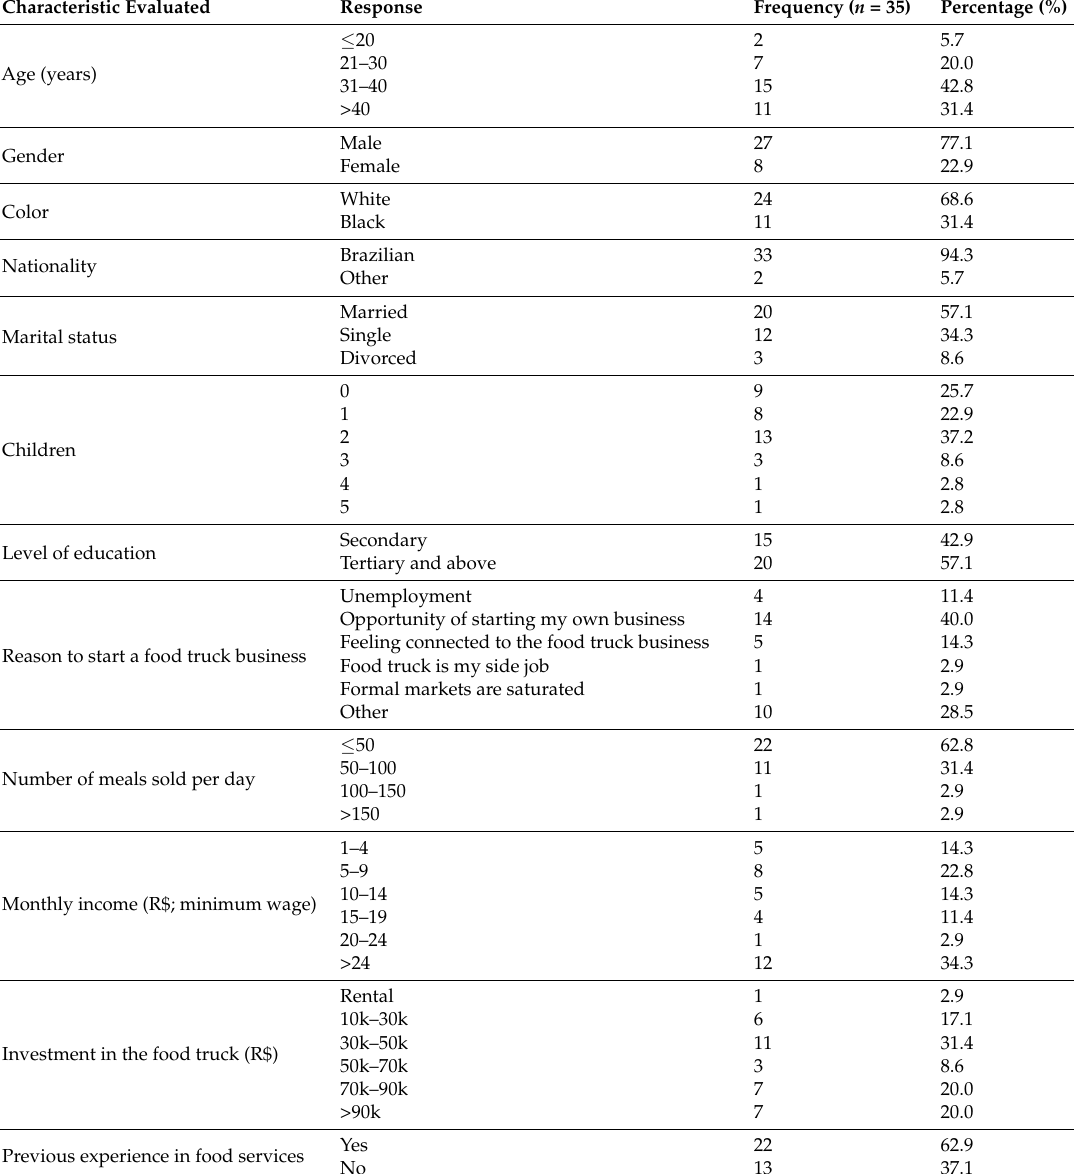
Table 1. Socio-demographic profile of food truck vendors studied in the Federal District,